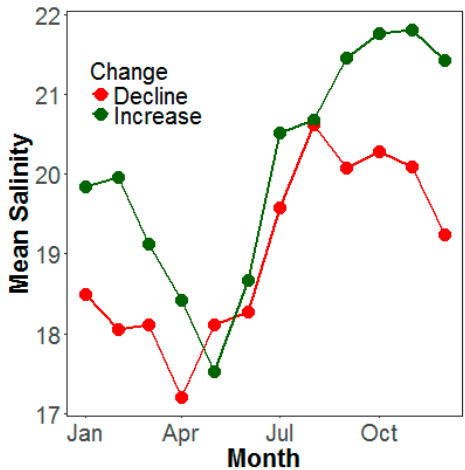
Figure 8. Mean salinity for every month comparing declining (red; 2001–2005 and 2009–2011), and increasing (green; 2006–2008 and 2012–2014) seagrass periods. Significant differences were found for every month ( p < 0.05). Data are from the NERRS SWMP continuous monitoring station at Goodwin Island, which records every 15-min, so sample sizes are very large, and significant differences appear even with small differences in means. Standard error bars are too small to appear on the plot.